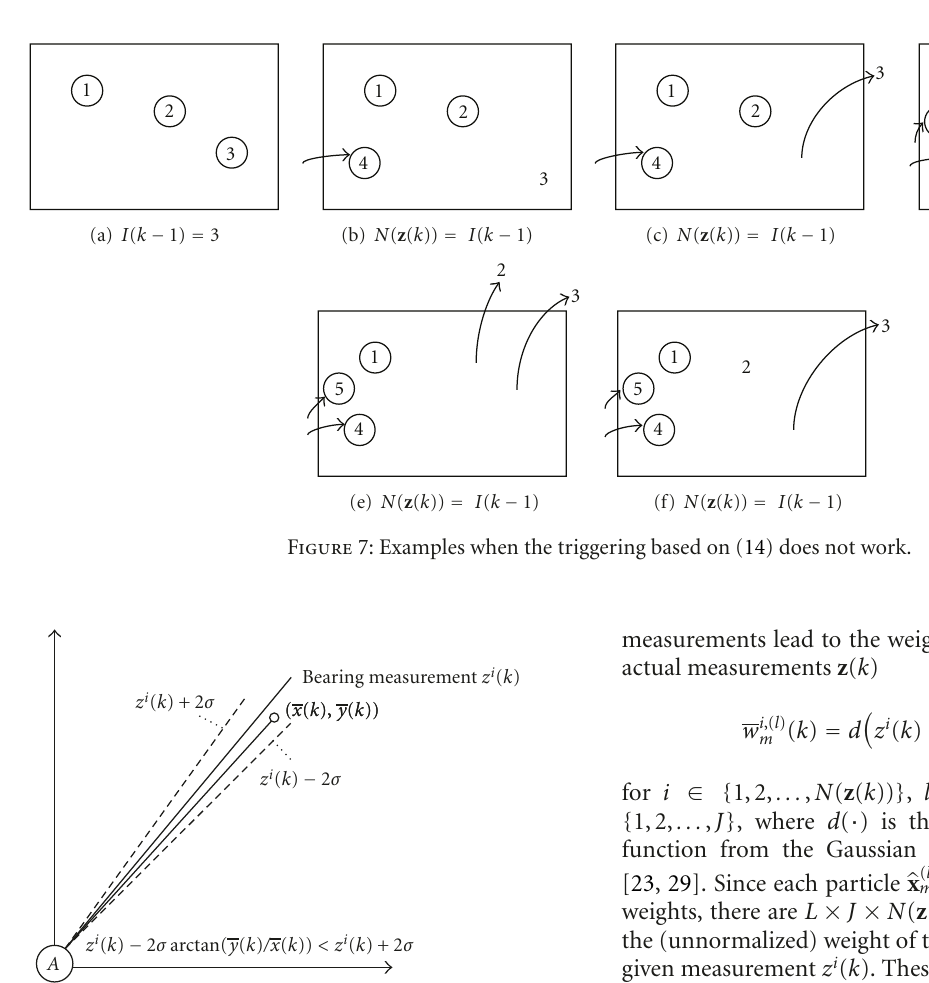
Figure 6: The triggering timings based on system dynamics.